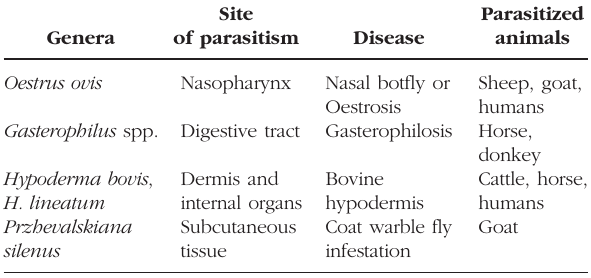
Table I. – Oestrid myiasis-causing larvae whose presence was recor- ded in the Mediterranean region: species, name of caused disease and animal host species